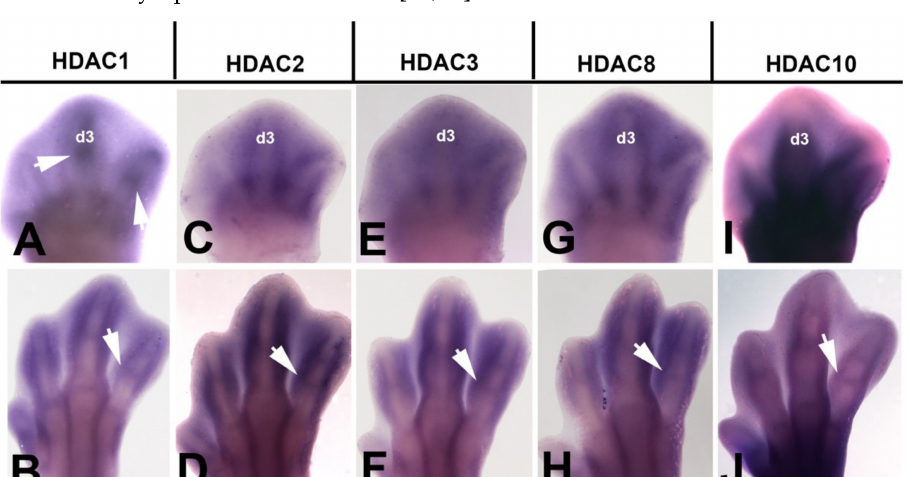
Figure 3. In situ hybridizations showing the interdigital expression of HDAC gene family at id 5.5 (28HH) ( A , C , E , G , I ) and 7.5 (32HH) ( B , D , F , H , J ). Note that class I HDAC genes, including Hdac1 , Hdac2 , Hdac3 , and Hdac8 , are expressed in the interdigital mesoderm and also in the joint regions. The class II gene Hdac10 ( I , J ) is expressed at lower levels than class I genes, but joint domains (arrow) are still identified at id 7.5 ( J ). Arrows indicate the expression domains in the developing interphalangeal joints. Digit 3 is indicated in all id 5.5 limbs as d3. Bar = 500 µ